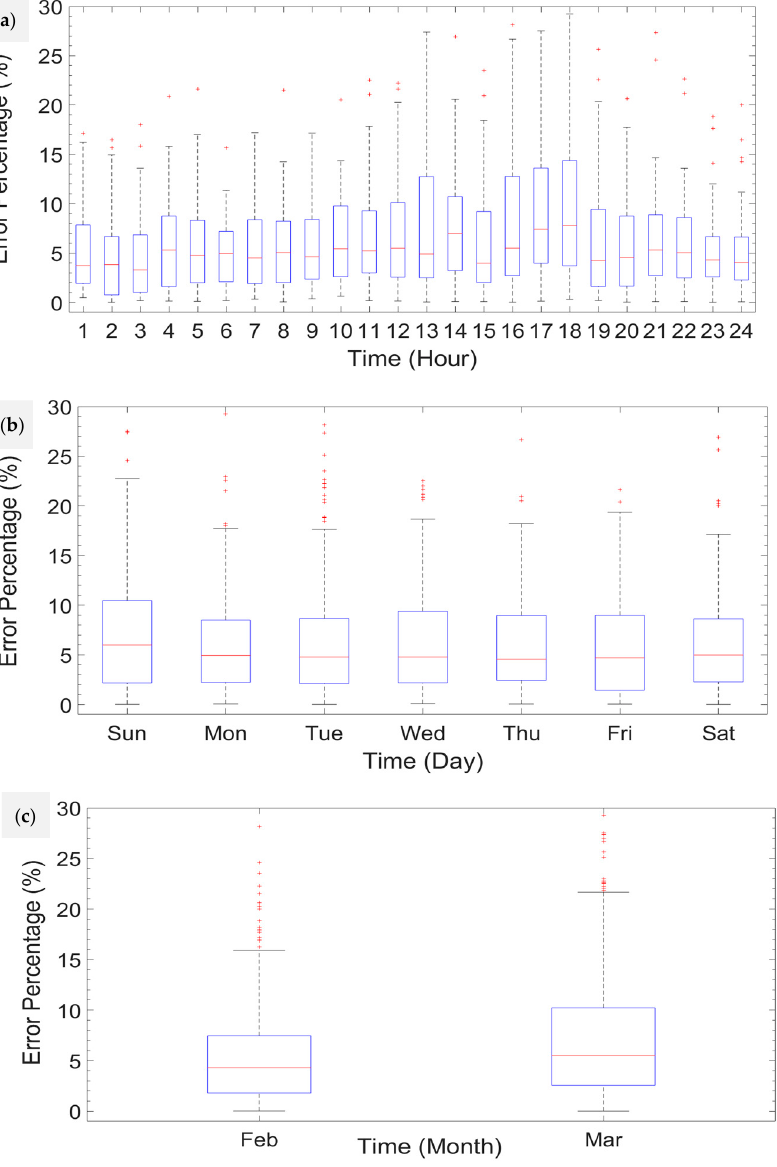
Figure 7. Distribution of percentage error during the forecasting period ( a ) Hourly ( b ) Daily ( c ) Monthly.